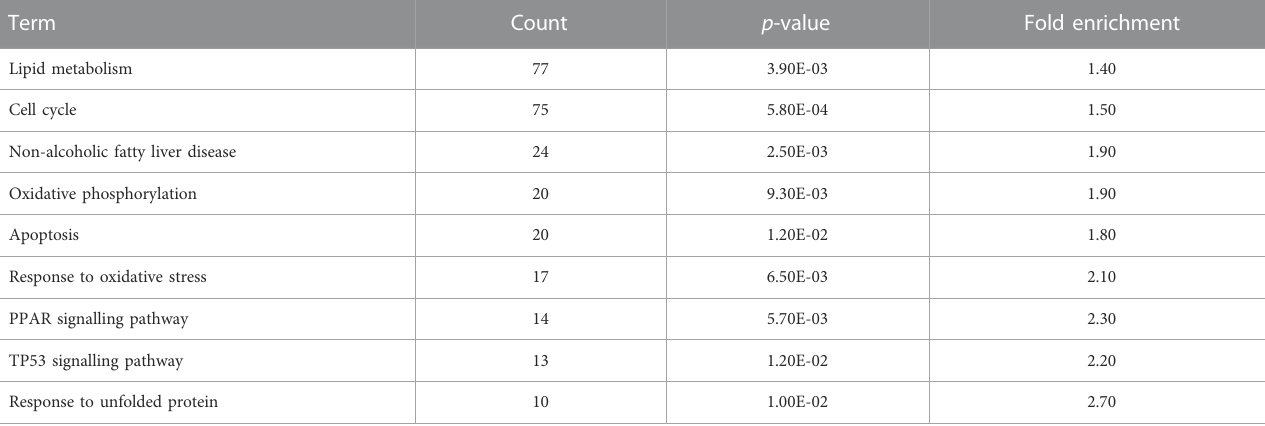
TABLE 1 Modular enrichment analysis of genes differentially expressed by palmitate exposure.